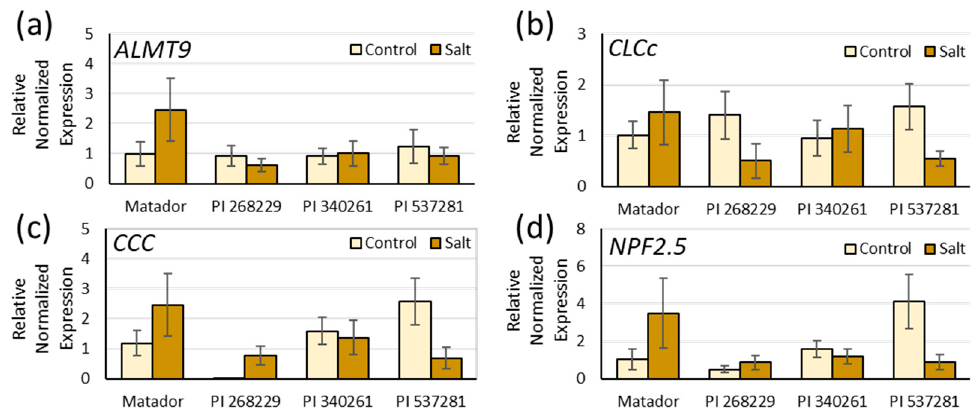
Figure 5. Expression of genes involved in Cl − transport in the roots of the four guar genotypes irrigated with control and saline irrigation waters ( n = 3). ( a ) ALMT9 . ( b ) CLCc . ( c ) CCC . ( d ) NPF2.5 . Error bars represent standard errors.